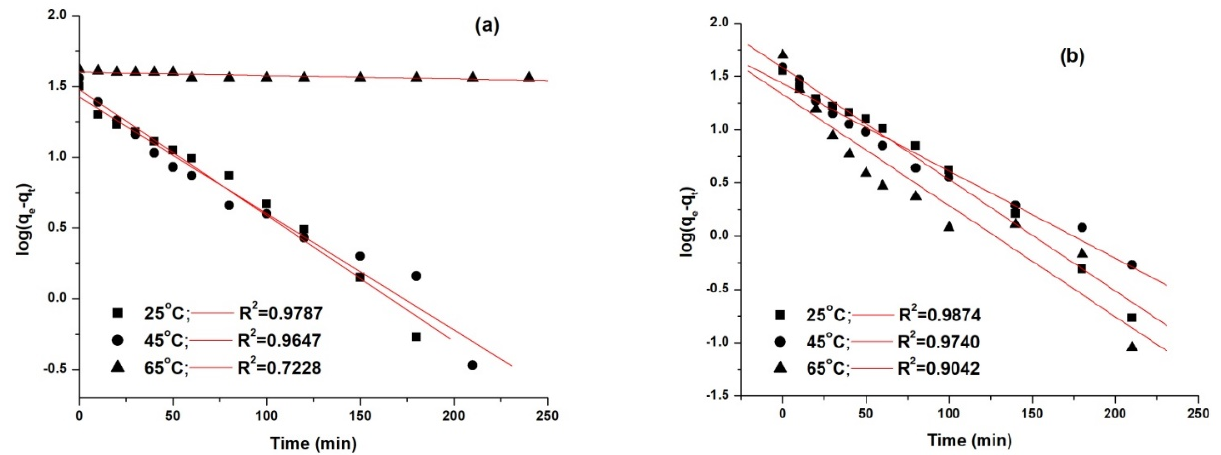
Figure 12. Pseudo first-order kinetic model fitting for the adsorption of AY 42 ( a ) and AR 213 ( b ) onto PM4.